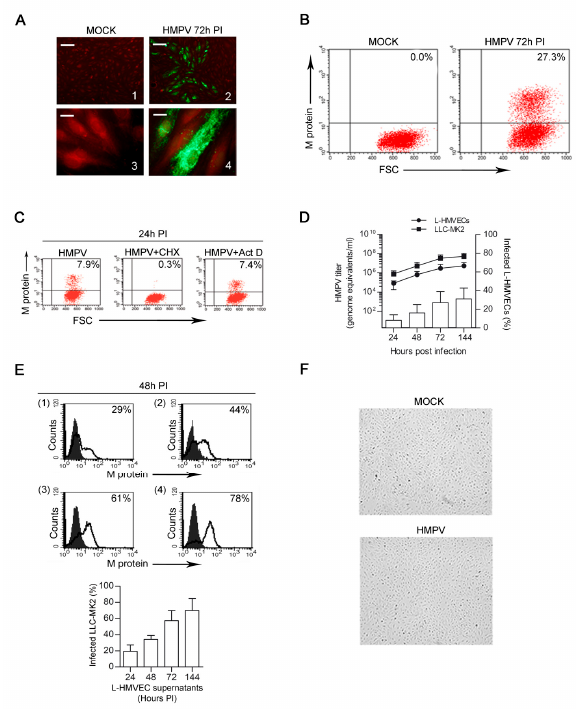
Figure 1. HMPV infection of L-HMVECs. ( A ) Fluorescent microscopy analysis of mock- (left panels) and HMPV-infected (right panels) showing the expression of viral antigens in infected cells. Staining of fixed cells was performed with a mAb to the matrix (M) protein followed by a secondary step with an Alexa Fluor 488 anti-mouse and finally counterstained with Evan’s Blue. Photographs illustrate mock-(1) and HMPV-infected (2) L-HMVECs where a focus of infection is shown (Scale Bar = 50 µ m). Enlarged images of mock-(3) or HMPV-infected (4) cells allow to visualize the typical HMPV punctate cytoplasmic staining (Scale Bar = 5 µ m). Images are representative of 5 independent experiments. Images were taken 72 h PI ( B ) HMPV-infected L-HMVECs were quantified by flow cytometry. Cells were mock-infected (left panel) or infected (right panel) with infectious HMPV and the presence of the M protein was detected as in (A). Fluorescence was measured using a FACScan and data obtained were analysed using the CELLQuest software. Results are displayed as dot plots. Panel images were taken 72 h PI. Percentages of HMPV + cells are shown in the upper right corner. ( C ) To confirm specificity of M protein staining, L-HMVECs were infected with HMPV in the presence or absence of 30 µ M cycloheximide or 1 µ M actinomycin D. Cells were analysed at 24 h PI ( D ) HMPV replication kinetic in L-HMVECs. Left scale: L-HMVECs were infected and cell culture supernatant samples were collected at the indicated time points. Quantitation over time of HMPV RNA present in purified nucleic acid derived from infected L-HMVEC ( • ) was determined by rtPCR. RNA derived from the permissive cell line LLC-MK2 infected with HMPV served as control of replication ( (cid:4) ). Data indicate mean viral loads (number of copies per mL of supernatant) ± SD of five independent experiments. Each quantitation was performed in three replicates. SD of the triplicate never exceeded 0.5%. Right scale: % of HMPV-infected L-HMVECs was quantified by flow cytometry, as described in A. Bars represent mean ± SD of five independent experiments ( E ) Release of infectious particles by L-HMVECs. LLC-MK2 were exposed for 3 h to the supernatants of HMPV-infected L-HMVECs harvested 24 (1), 48 (2), 72 (3), and 144 (4) h PI. After two days, the infected LLC-MK2 cells were quantified by flow cytometry. Fluorescence was measured using a FACScan and data obtained were analysed while using the CELLQuest software. In the upper panel histograms from one representative experiment out of three with similar results are shown. Solid graphs represent data obtained from LLC-MK2 exposed to supernatants derived from mock L-HMVECs. Percentages of HMPV + cells are shown in the upper right corner of each panel. In the lower panel, bars represent the mean ± SD of the % of HMPV-infected cells detected in all the experiments performed ( F ) Light microscopy evaluation of uninfected (upper panel) and HMPV-infected monolayers (lower panel) at 6 days PI. ECs completely retain their characteristic morphology (Scale Bar = 50 µ